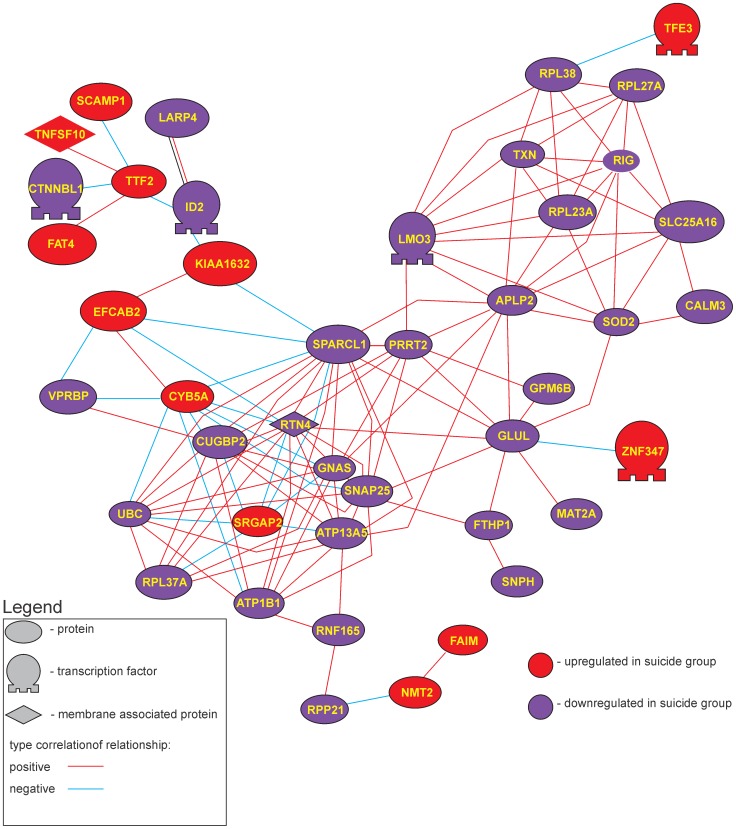
Pearson’s correlation based gene network for differentially expressed genes for the control cohort.Red nodes represent genes up-regulated in the depressed suicide group, blue nodes represent genes down-regulated in the depressed suicide. Network contains 45 genes connected by 134 correlation relationships higher than 0.8.